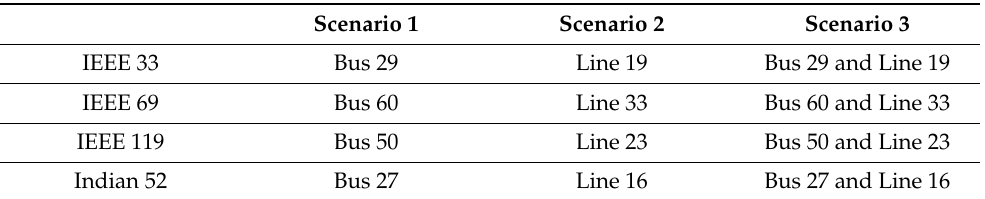
Table 2. Description of scenarios 1, 2, and 3 for all test systems.